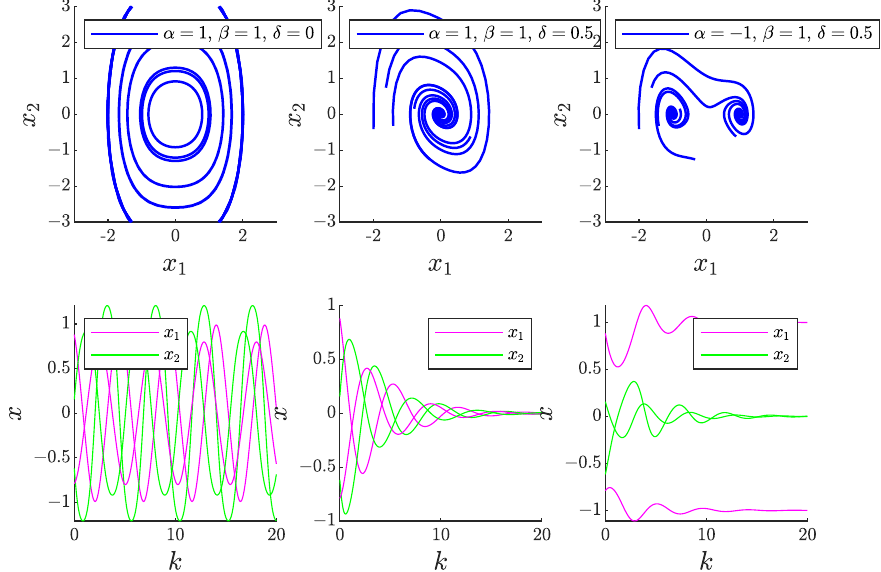
Figure 1. Orbits of the Duffing equation for different parameterizations. ( Left ): undamped, ( Center ): hard spring, ( Right ): soft spring, ( Top row ): phase plane, ( Bottom ): states versus time of two